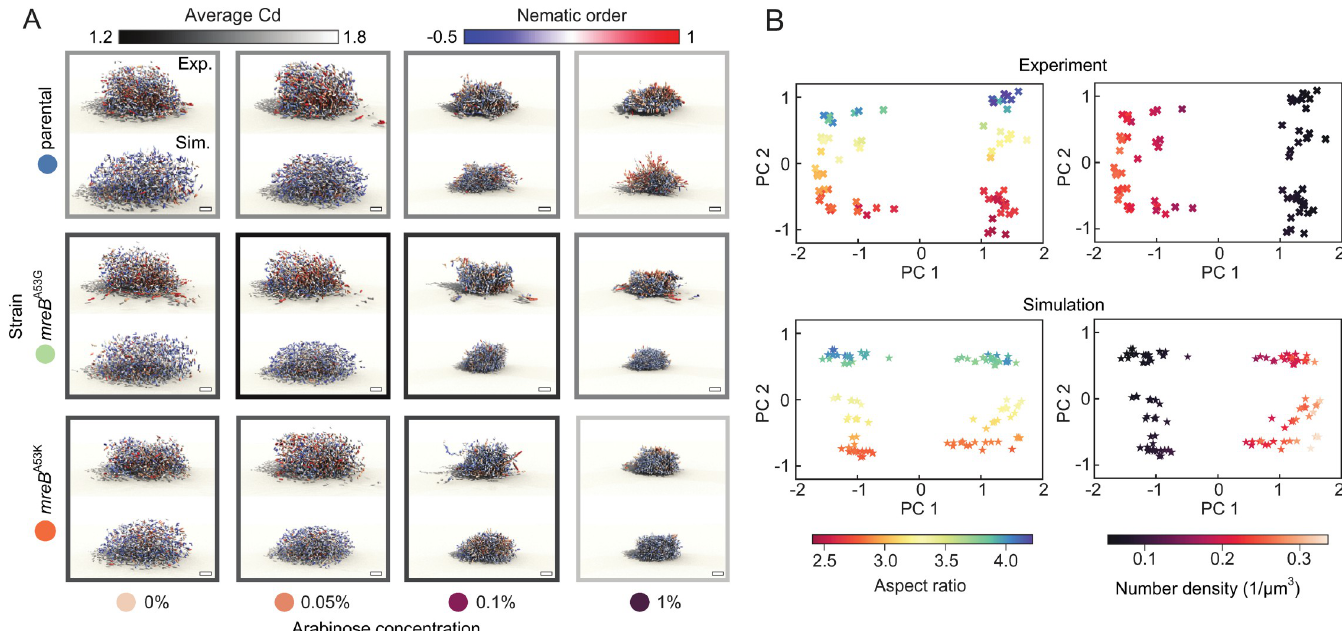
Fig 3. Experiments and simulations show that differences in biofilm architecture are driven by cell aspect ratio and cell–cell adhesion. ( A ) Renderings of V . cholerae biofilms (top, N cell approximately 2,000) and corresponding best-fit simulations (bottom, N cell = 2,000) for combinations of 3 different mutants (arranged vertically) and 4 different arabinose concentration levels (arranged horizontally). Each cell in the biofilm is colored by the local nematic order around it. The outline of each grid panel is colored in grayscale by the average Cd between the corresponding experiments ( n = 3) and the best-fit simulation (see Fig J in S1 Text for the exact values). Scale bar, 5 μ m. ( B ) Two-dimensional PCA embedding of the Chebyshev features of n = 72 V . cholerae mutant biofilms (top) and a group of n = 114 simulations consisting of the top 5 best-fitting simulations (bottom) for each combination of strain and arabinose concentration. The PCA embedding is colored by average aspect ratio (left) and average local number density (right) of all the cells in each biofilm, confirming that these 2 parameters are principal determinants of biofilm architecture, consistent with Fig 1E. Source data are available at DOI: 10.5281/zenodo.7077624. Cd, Chebyshev dissimilarity; PCA, principal component